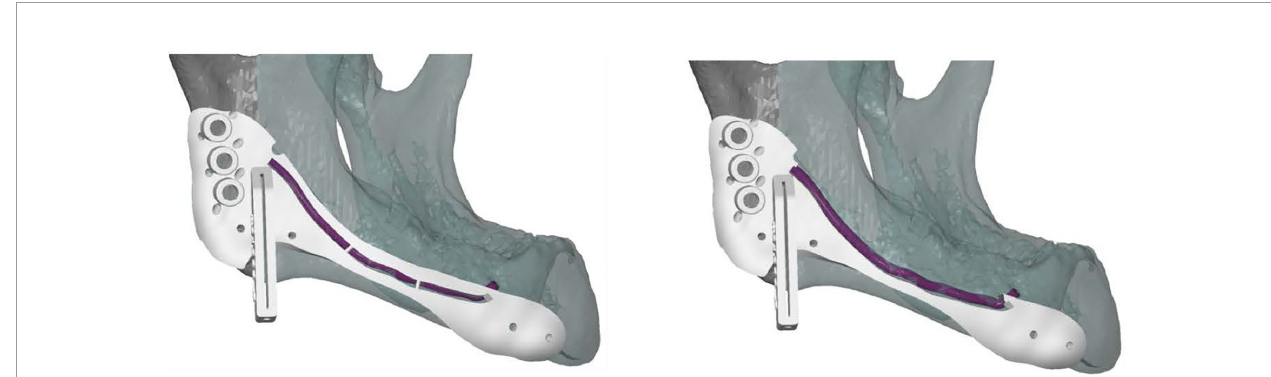
FIGURE 5 | Lateral view of a cutting guide, allowing two-step exteriorization of the inferior alveolar nerve. The purple line indicates the inferior alveolar nerve. The guide shows three drilling holes on the left for plate fi xation surrounded by small holes for water cooling during drilling. The guide also includes a saw box to create the osteotomy plane. The two small holes surrounding the saw box and the two small holes on the right side of the guide are used for fi